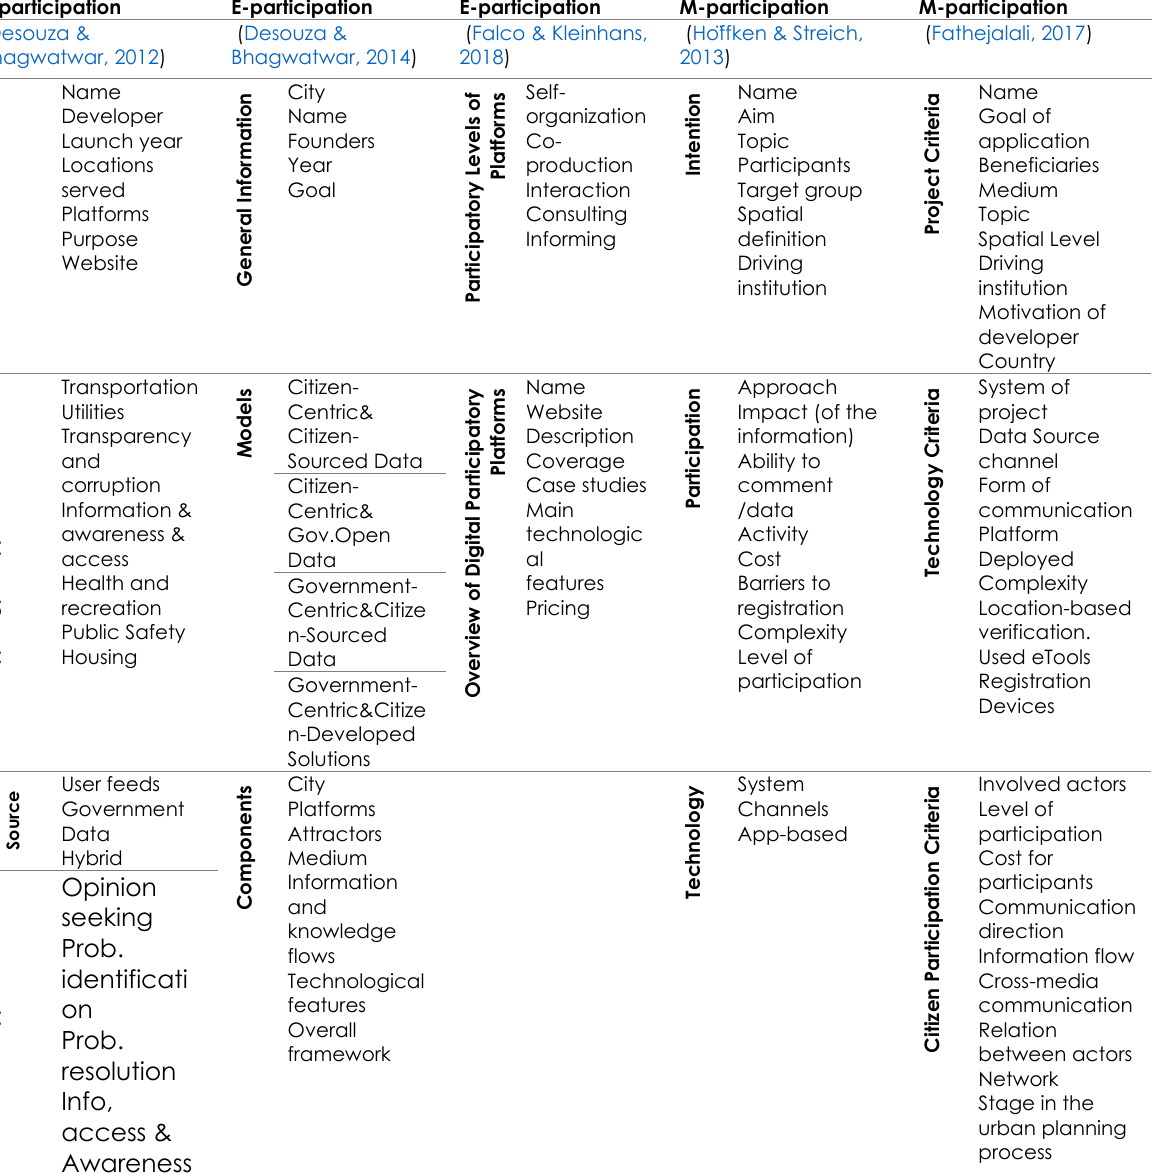
Table 3. Evaluation Criteria for Participatory Platforms from Different Perspectives E-participation